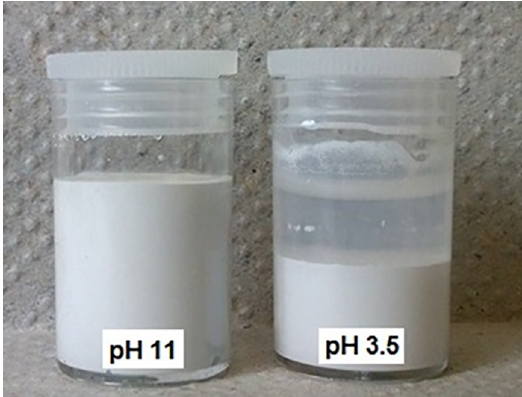
Figure 6. Sedimentation tests of alumina suspension defloculated with HA in alkaline (left) and acidic medium (right). One week at rest.